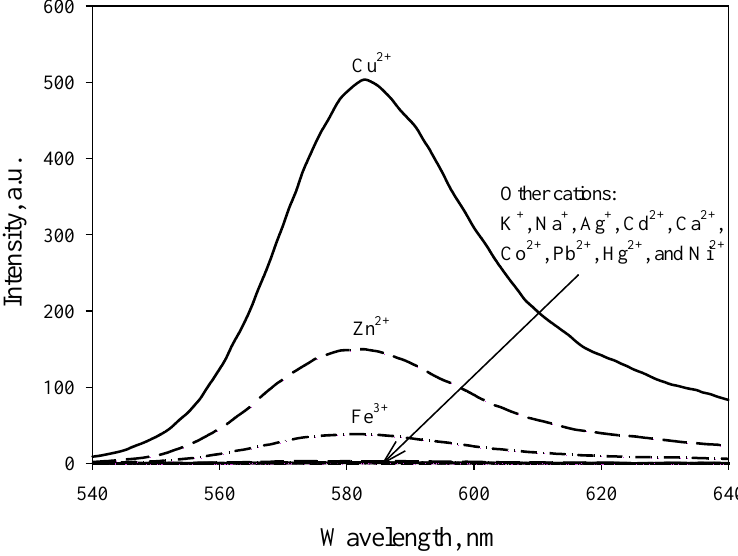
Figure 2. Fluorescence spectra ( λ ex = 530 nm) of RECM (50 µM) in CH 3 CN in the presence of various competitive cations (30 µM).